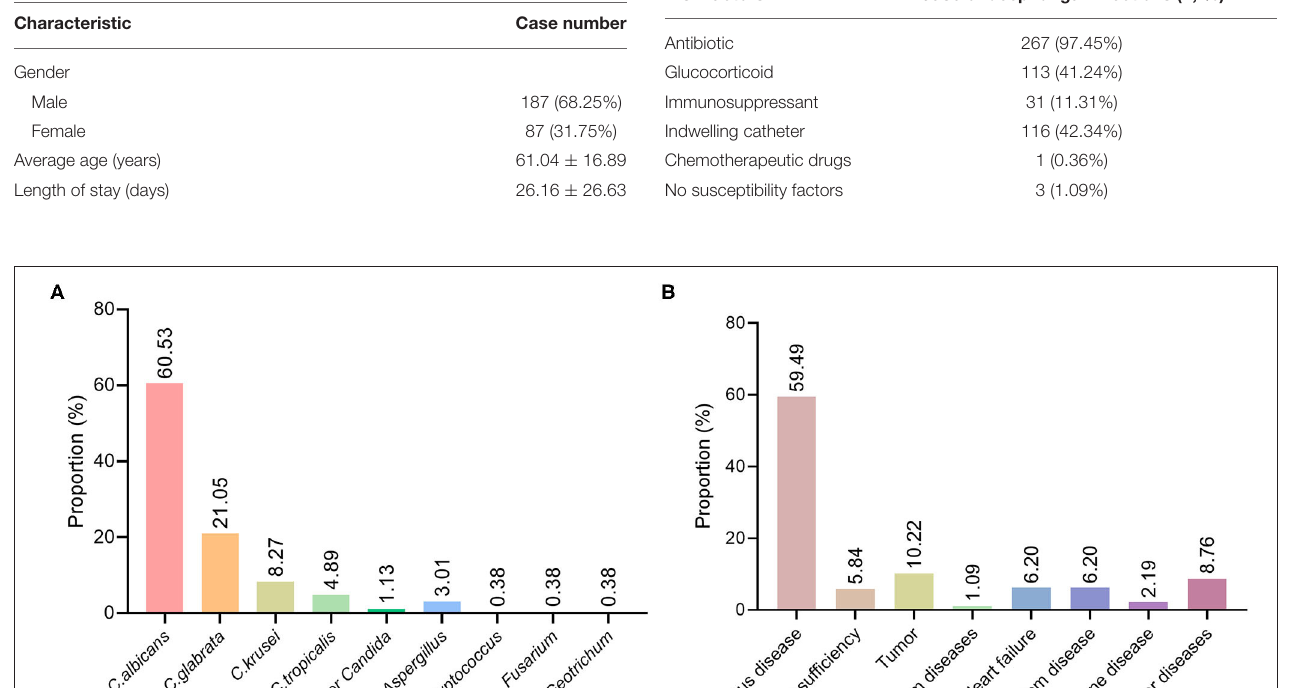
Frontiers in Public Health |